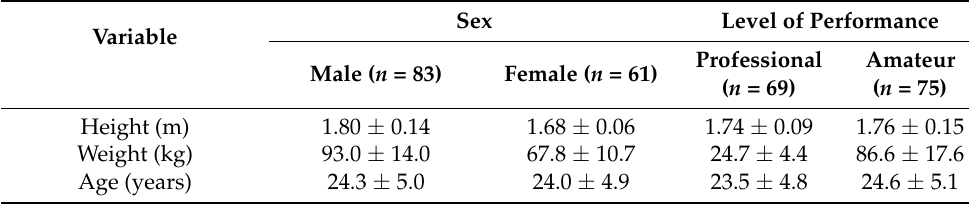
Table 1. Characteristics data of the